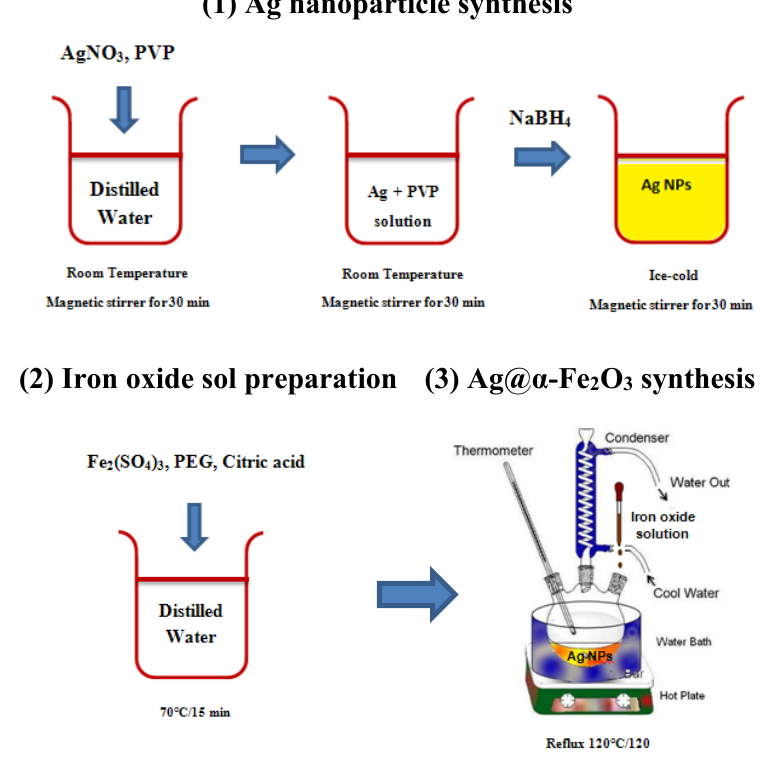
Figure 11. Schematic representation of synthesis procedure of Ag@Fe 2 O 3 core-shell